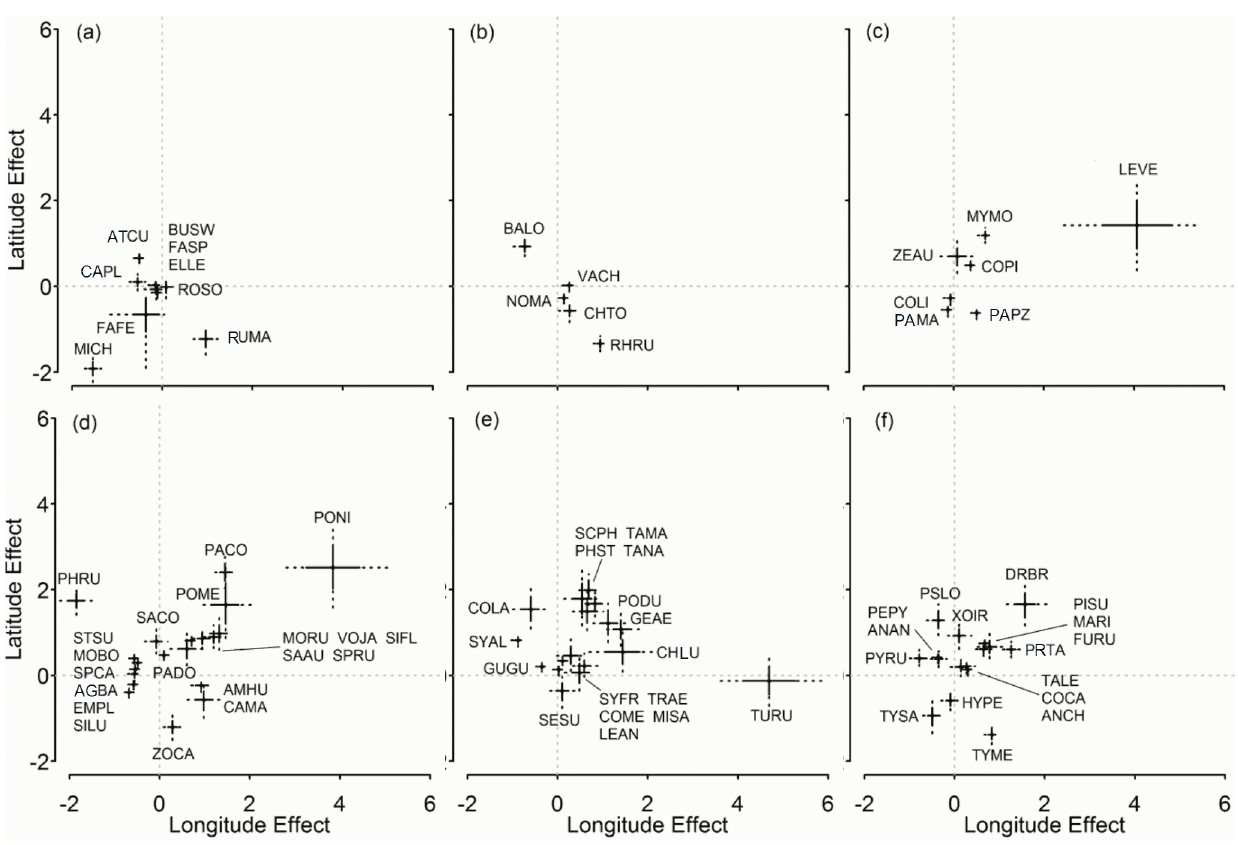
^ β ± Fig 5. Latitude and longitude coefficients in the logit scale ( SD, 95% BCI) on logit occupancy (logit ^ ψ ) of each bird species in the regional bird monitoring program in Argentina, 2003 – 2012. (a) Raptors; (b) ground omnivores and herbivores; (c) ground granivores; (d) other granivores; (e) insectivores mostly associated with folliage; (f) other insectivores. For details of species names and guilds, see S1